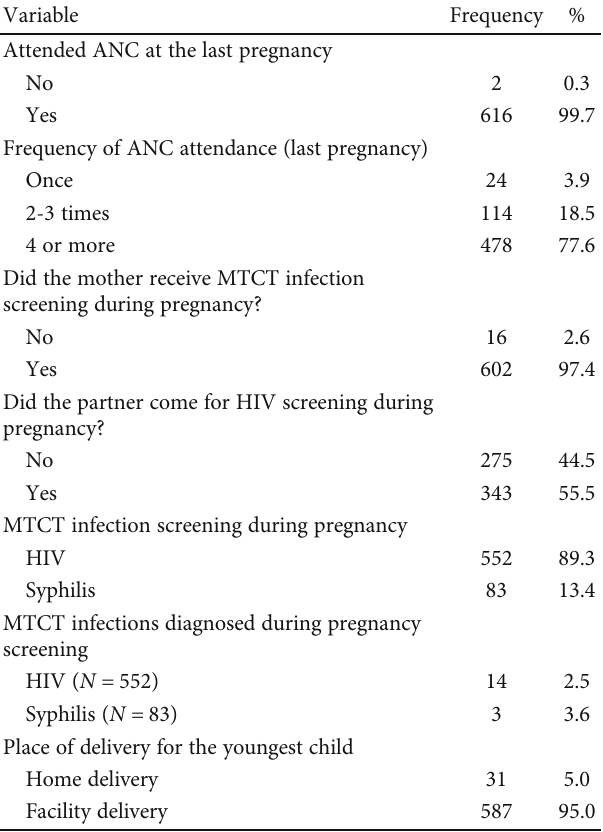
Table 3: Knowledge of MTCT infections among 618 women in the Kilimanjaro